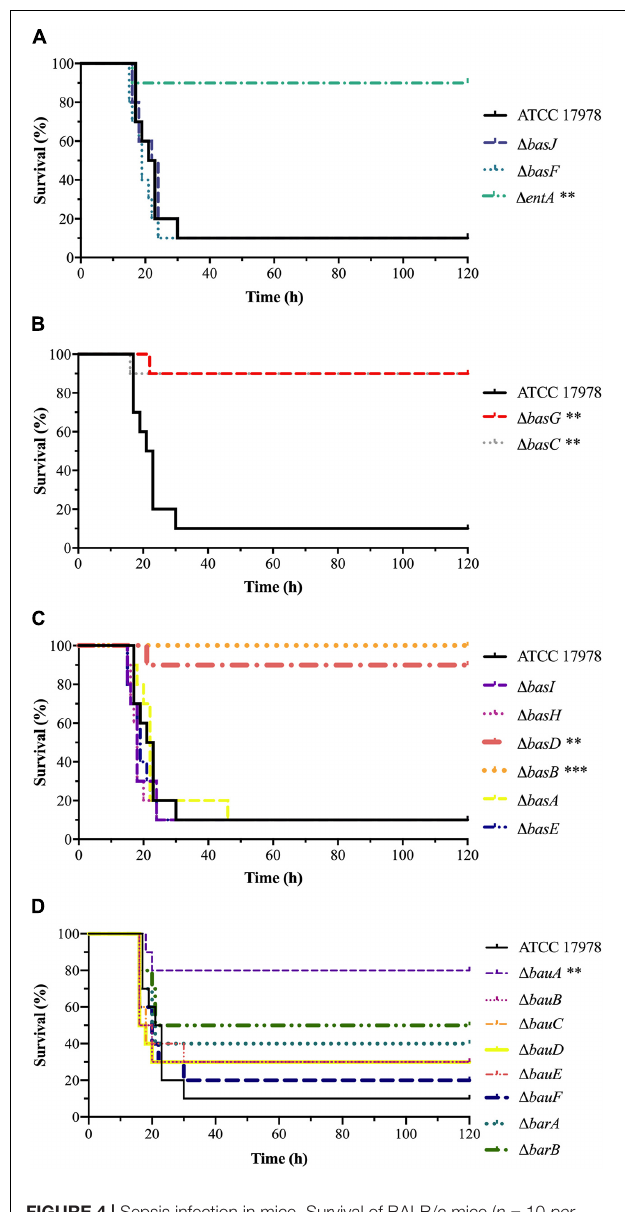
FIGURE 4 | Sepsis infection in mice. Survival of BALB/c mice ( n = 10 per group) after bacteremia infection with A. baumannii ATCC 17978 and the isogenic mutant derivative strains lacking (A) genes involved in the synthesis of the DHBA precursor, (B) genes involved in the synthesis of the N -hydroxyhistamine precursor, (C) genes involved in the modification and assembly of the acinetobactin precursors into the final molecule and (D) genes involved in the acinetobactin transport The log-rank (Mantel-Cox) test was used for statistical analysis ( ∗∗ P < 0.01, ∗∗∗ P < 0.0001).